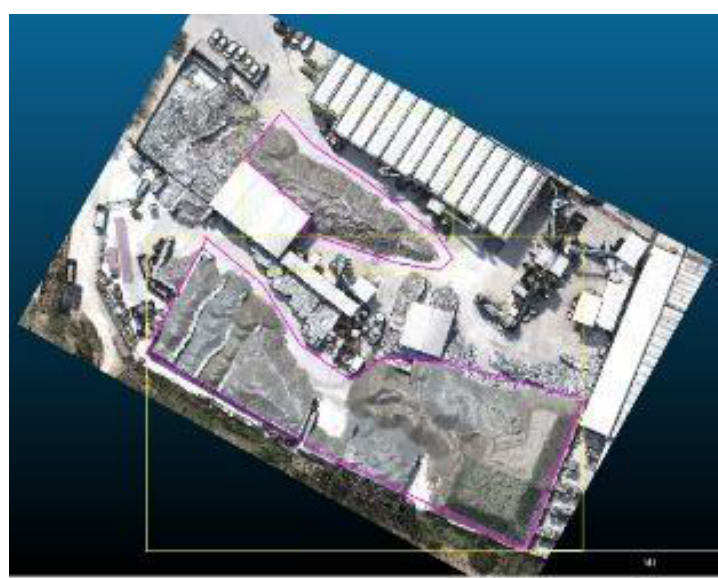
Figure 25. Stockpiles compared with CloudCompare software.